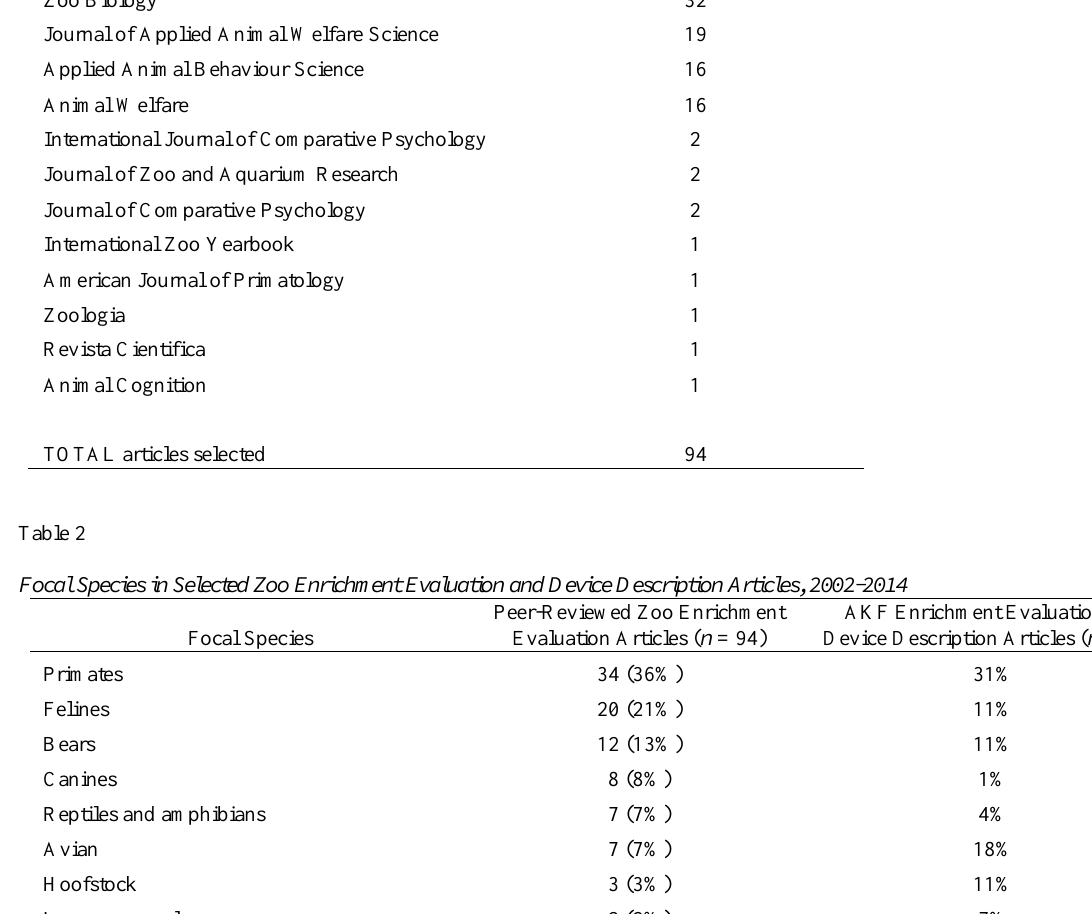
Other mammals (armadillo, anteater, peccary, wombat, two-toed sloth, river otters)